Question: Summarize what this figure shows in one sentence.
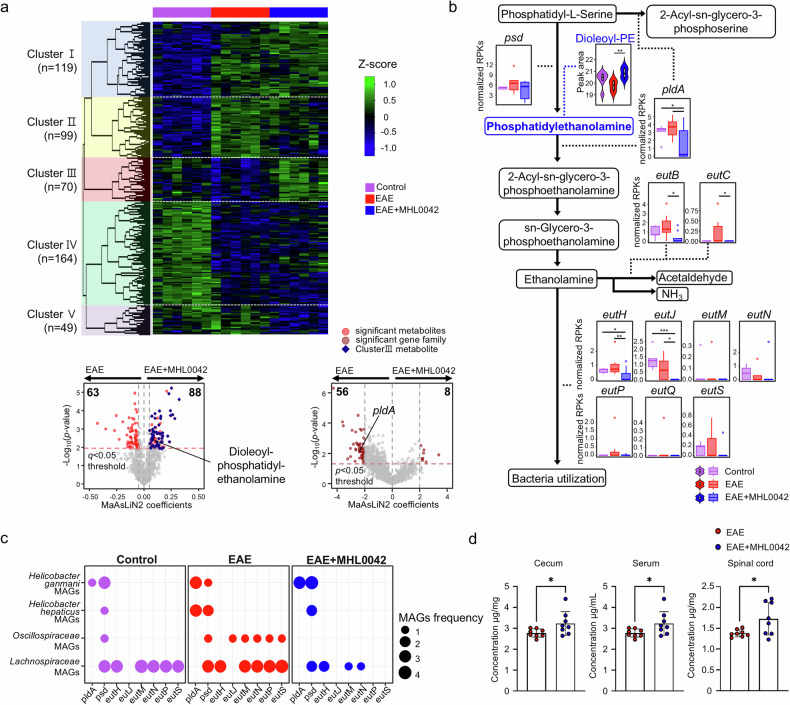
Answer: Comparison of cecal metabolites and associated microbial functional genes across groups. a Heatmap of significantly altered non-target metabolites among the treatment groups, with hierarchical clustering based on Spearman correlation. Volcano plots show differentially enriched metabolites and KEGG gene families between the experimental autoimmune encephalomyelitis (EAE) and EAE + Veilonella ratti MHL0042 groups. Significant features were identified using MaAsLiN2 ( q < 0.05; | ρ | > 0.05 for metabolites, | ρ | > 2 for gene families). b Schematic representation of phosphatidylethanolamine biosynthesis pathways annotated with relevant gene families. P -values calculated using MaAsLiN2. * P < 0.05; ** P < 0.01; *** P < 0.001. c Metagenome-assembled genomes were reconstructed from individual samples, and microbial contributors to phosphatidylethanolamine biosynthesis-related gene families were identified. Dot size represents the frequency of metagenome-assembled genomes harboring each gene family within each treatment group, linking microbial taxa to their associated functional genes. d Quantification of dioleoyl phosphatidylethanolamine in the cecum, serum, and spinal cord. Data are presented as mean ± standard deviation from EAE ( n = 8) and EAE + V. ratti MHL0042 ( n = 8) groups. Statistical comparisons were performed using unpaired Student's t test. * P < 0.05.